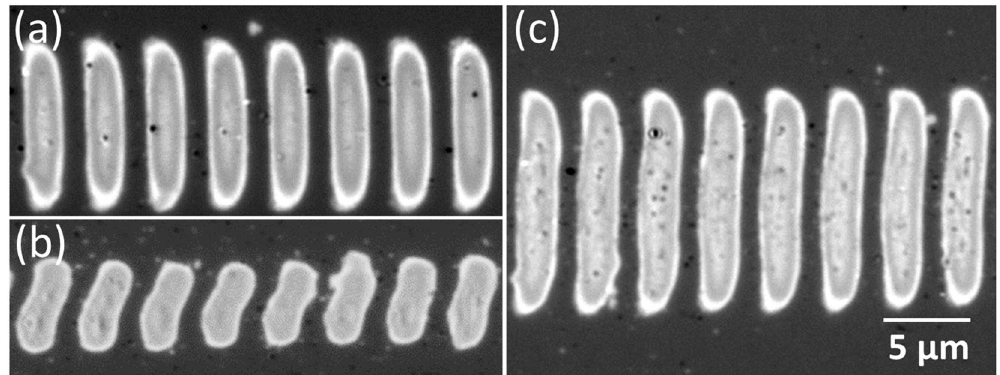
Figure 6. Optical micrographs of amorphous fringes with constant period Λ s + but different length, obtained by changing spot diameter d and laser fluence F . ( a ) d y = 59 µ m , F = 146 mJ / cm 2 , v = 360 µ m / s ( b ) d y = 22 µ m , F = 190 mJ / cm 2 , v = 100 µ m / s ( c ) d y = 59 µ m , F = 148 mJ / cm 2 , v = 360 µ m / s